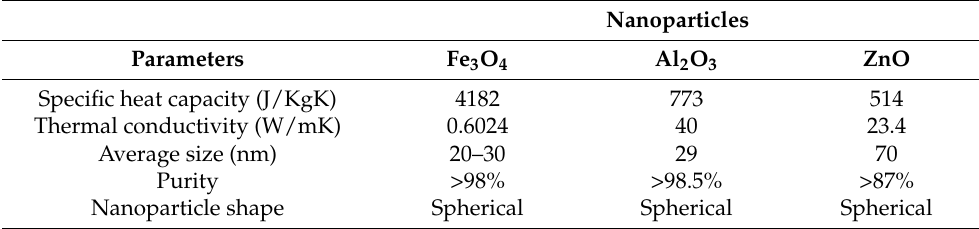
Figure 4. Particle size distribution of Al 2 O 3 -ZnO hybrid nanocomposite. Table 1. Thermo-physical properties of synthesized